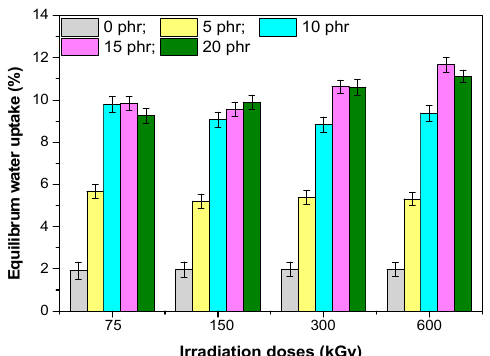
Figure 12. Equilibrium water uptake in depending on the dose of irradiation for composites based on EPDM and hemp fiber.